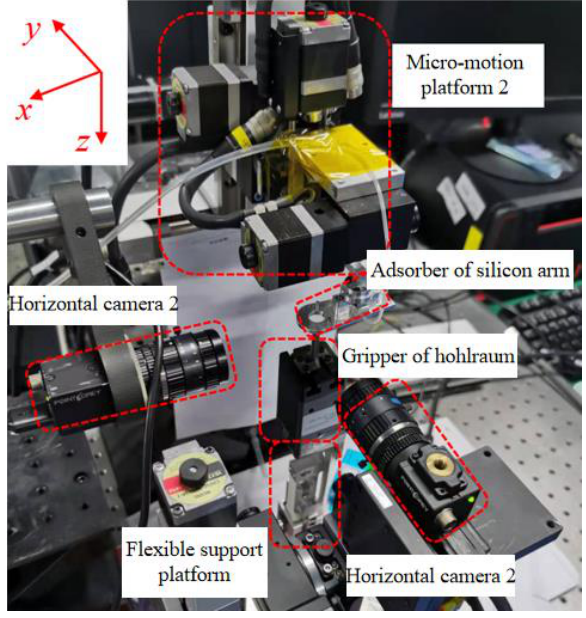
Figure 14. Flexible assembly platform of TMP component and hohlraum.